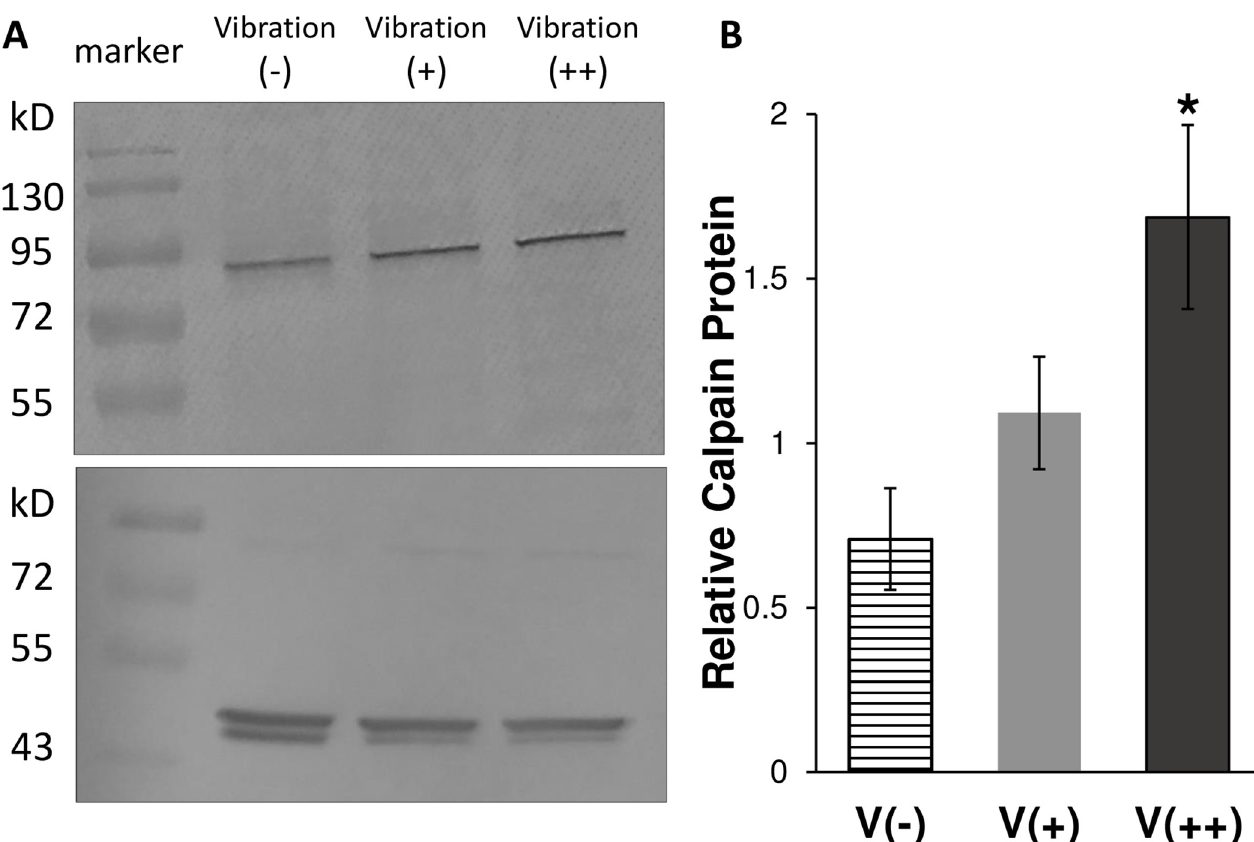
Fig 4. Vibration stimulates increase in calpain protein. Representative immunoblot of cytoplasmic lysates from HeLa cells without vibration (vibration -) or with increasing levels of vibration [vibration (+) and vibration (++) representing 600 and 1200 rpm, respectively]. Lysates probed for calpain-1 [top panel] and beta-actin [bottom panel] as a loading control. Similar levels of beta-actin support that calpain increase was not a consequence of loading differences. Marker indicates molecular marker bands corresponding to protein size (kD) (A). Relative calpain-1 protein, a ratio of the calpain-1 to beta-actin band peak densities for each immunoblot (n = 3), expressed as average ( ± sem for three independent experiments). (B). � = p < 0.05 Vibration (++) [dark, solid bar] vs. Vibration (-) [striped bar]. No significant difference noted between Vibration (+) [gray bar] vs. Vibration (-).